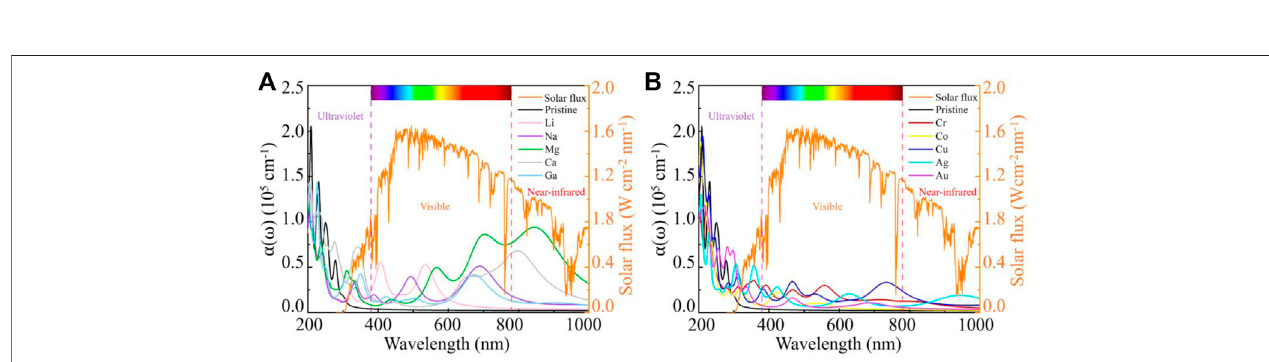
FIGURE 6 | Absorption spectrum of intrinsic g-ZnO and (A) M or (B) TM adsorbed g-ZnO systems.